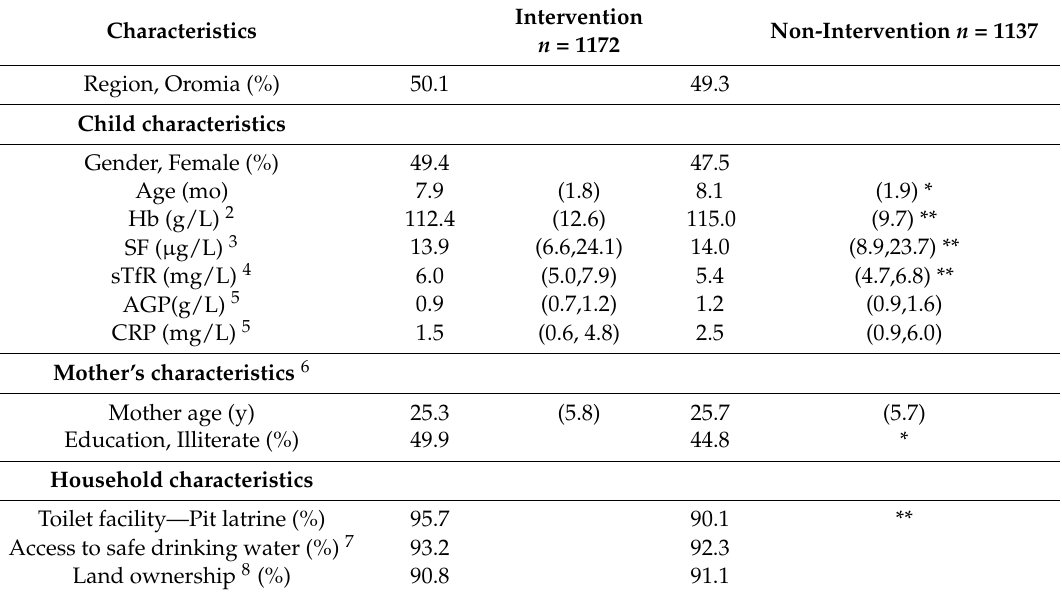
Table 2. Baseline characteristics of the study participants 1